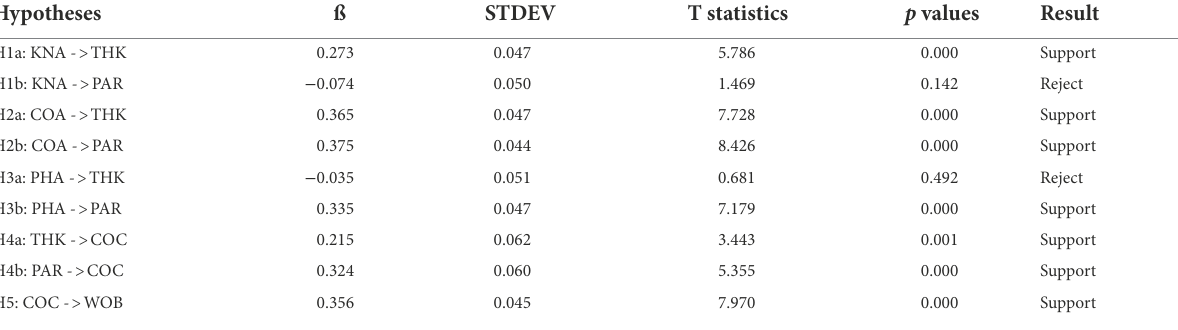
TABLE 3 Hypothesis testing